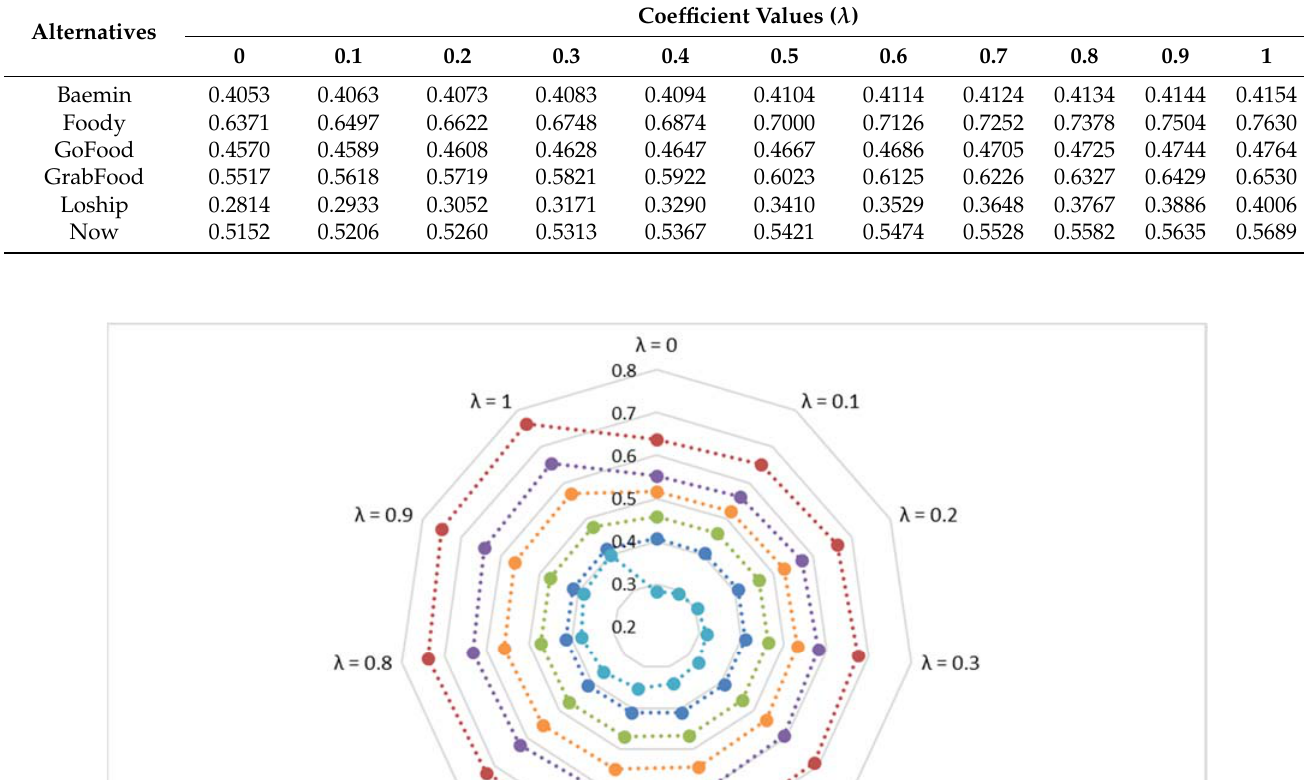
Table 12. The final appraisal scores of WASPAS model.